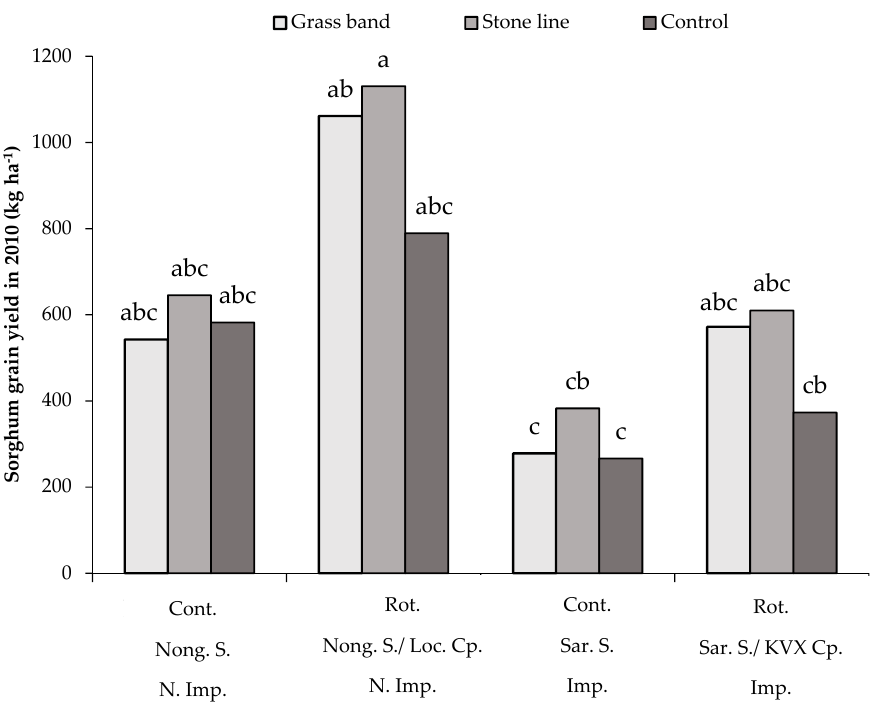
Figure 7. Sorghum grain yield of the two sorghum varieties in continuous cropping or rotation with cowpea according to WCM at Saria Research Station, Burkina Faso, in 2010. Abbreviations: Cont.: Continuous; Rot.: Rotation; Nong. S.: Nongomsoba Sorghum; Sar. S.: Sariaso 14 Sorghum; KVX Cp.: KVX 396-4-4 Cowpea; Loc. Cp.: Local Cowpea; N. Imp.: Nonimproved; and Imp.: Improved. Columns with the same letter are not significantly different at p < 0.05.